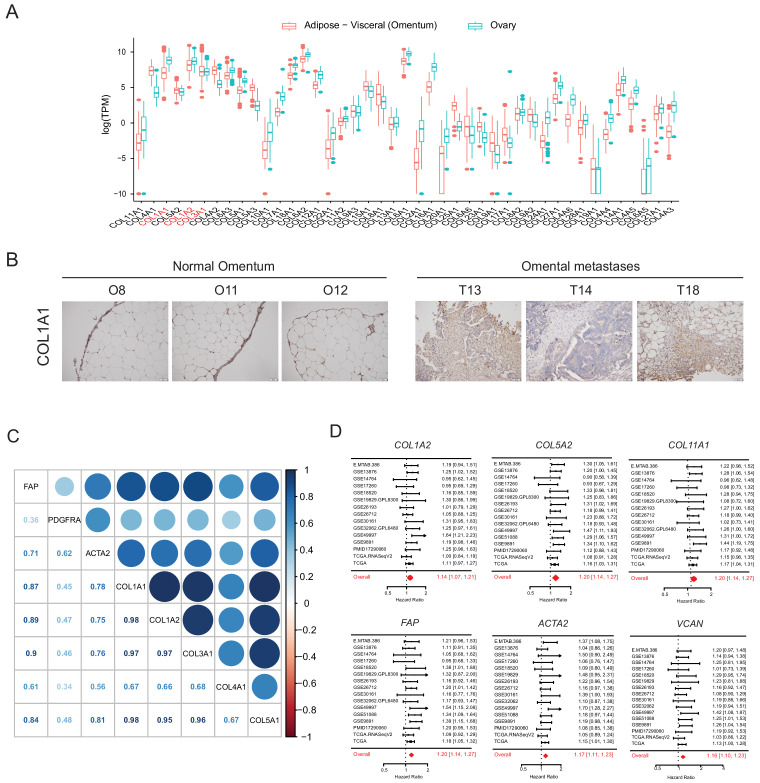
Collagens and ECM-associated gene expression correlates with poor survival in patients with ovarian cancer.(A) Box-whisker plots shows gene expression of 43 collagens (log(TPM)) in normal ovary and omentum tissue from GTEx database. COL1A1, COL1A2, and COL3A1 are the highest expressed collagen genes in ovary and omentum (red) (B) Representative immunohistochemistry staining of COL1A1 in normal omentum and omental metastasis. (C) Correlation matrix of selected fibroblast activated markers and collagen in TCGA dataset. Numbers indicate Pearson correlation coefficients. Positive correlations are displayed in blue and negative correlations in red color. Color intensity and the size of the circle are proportional to the correlation coefficients. Correlations with p-value < 0.01 are considered significant. (D) Forest plots summarize the mRNA expression of indicated gene as a univariate predictor of overall survival in the curatedOvarianData (n = 2970). FAP, fibroblast activated protein. VCAN, versican. ACTA2, smooth muscle actin.